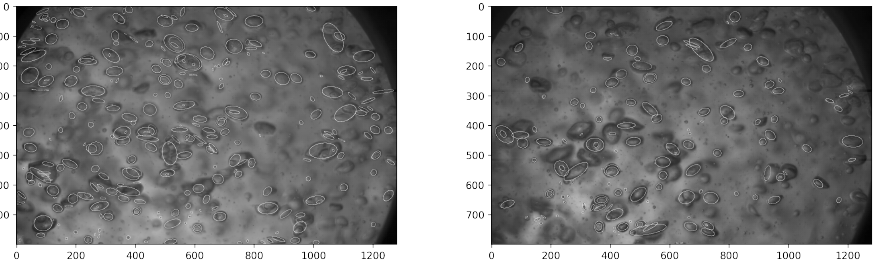
Figure 15. Successful ( left ) and unsuccessful ( right ) frame samples. In the successful frame there are generally more medium-sized bubbles, while the unsuccessful frame is